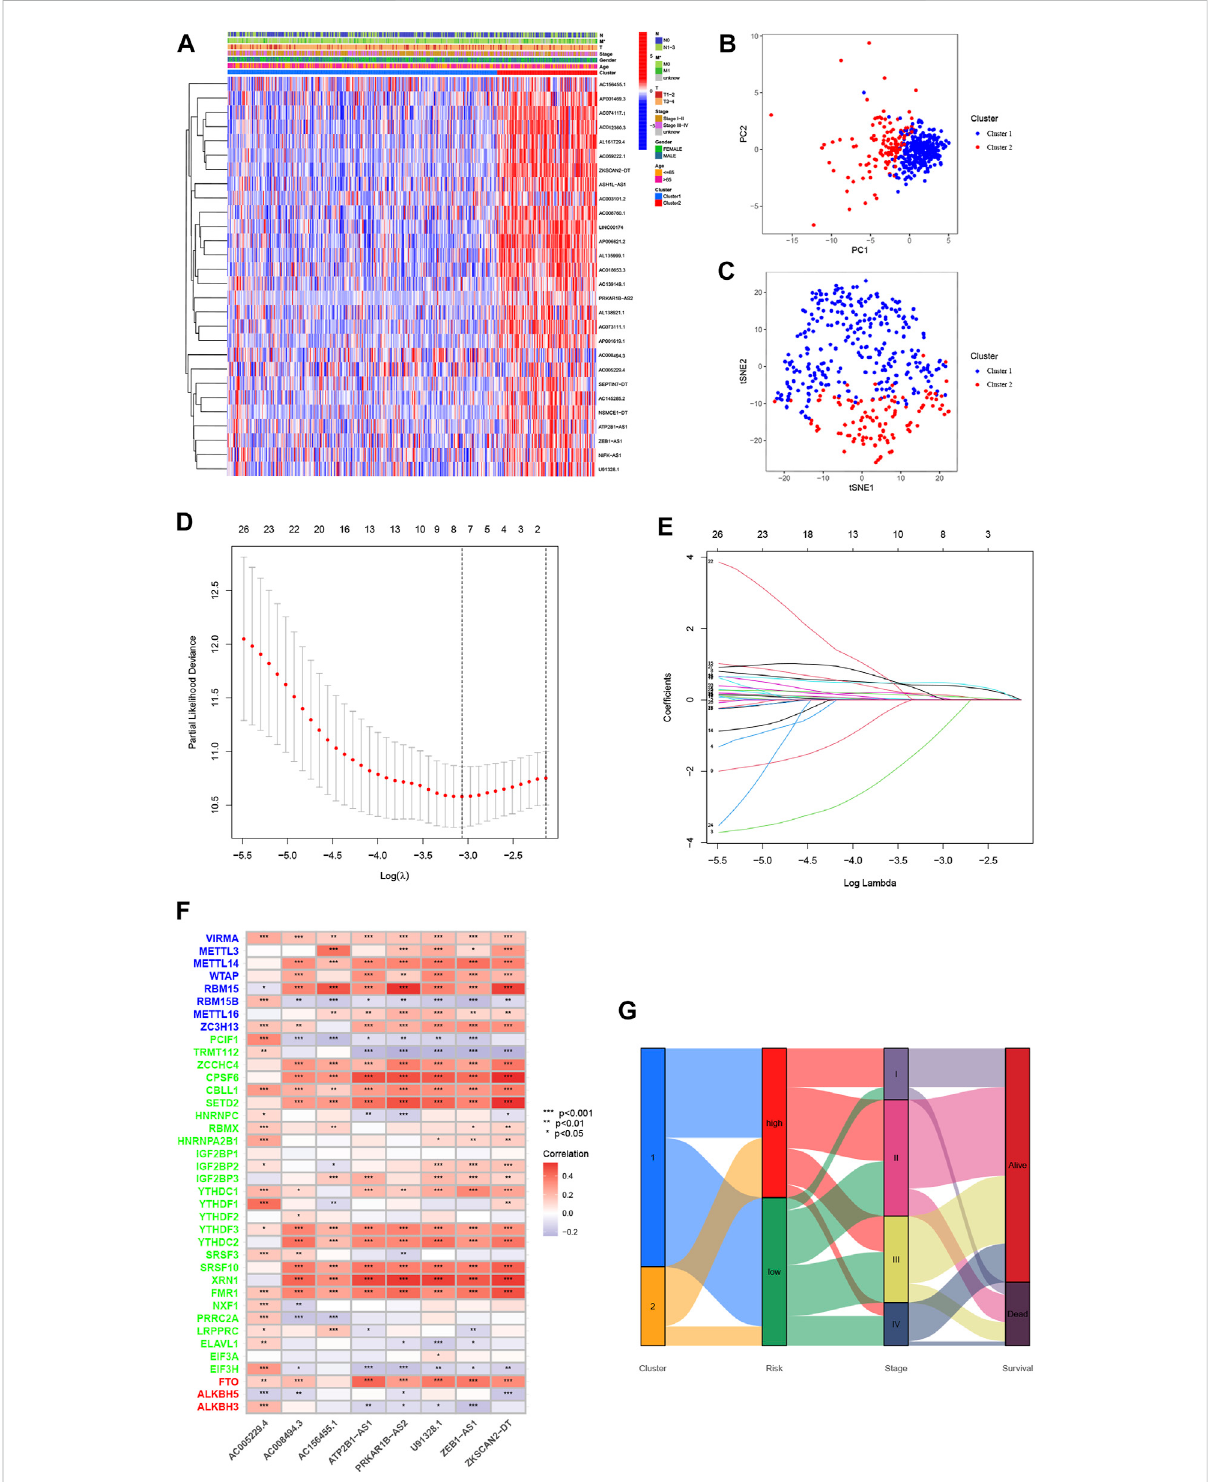
FIGURE 4 Characterizationofcluster1/2subtypesandconstructionofm6A-relatedlncRNAsignaturesbasedon28m6A-relatedlncRNAs. (A) Heatmapof the associations between the cluster 1/2 subtypes and clinical characteristics. (B,C) The cluster 1/2 subtypes based on 28 m6A-related prognostic lncRNAs were performed to Principal Component Analysis (B) and t-Distributed Stochastic Neighbor Embedding (C) analysis. (D) Plots of the minimum 10-fold cross-validation to select the tuning parameter in the LASSO regression. (E) The LASSO coef fi cient of 28 m6A-related prognostic lncRNAs. (F) Heatmap for the correlations between all m6 A genes and the 8 prognostic m6A-related lncRNAs. (G) Alluvial diagram of subtype distributions in groups with different m6A-related lncRNA signatures and survival outcomes. * p < 0.05; ** p < 0.01; *** p <